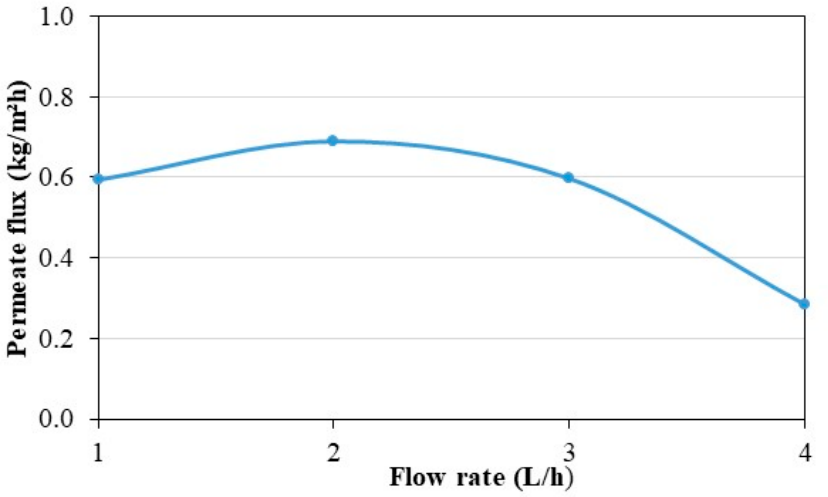
Figure 15. Effect of flow rate on permeate flux in controlled mode. The on/off control of the compressor in storage mode gives a particular dynamic to the temperatures of the hot and cold fluids in the AGMD module as seen in Figure